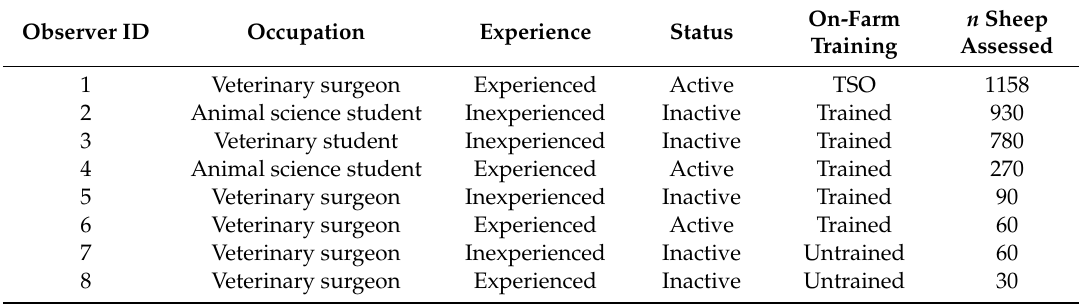
Table 1. Observer identity, occupation, experience, activity and training status, and number of sheep assessed by the test standard observer (“TSO”) and other study